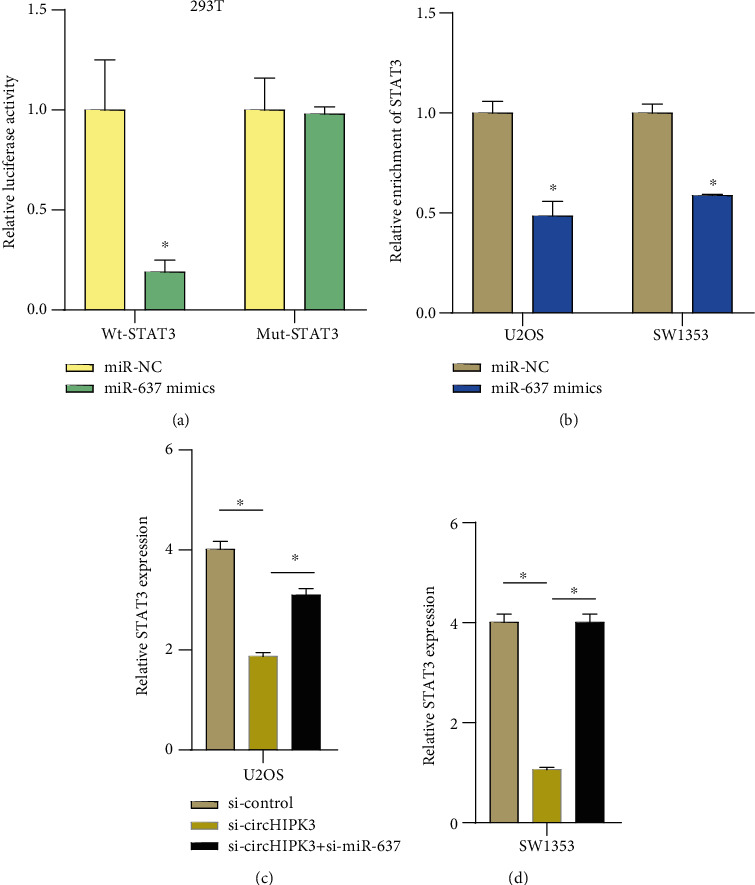
STAT3 was a direct target of miR-637. (a) miR-637 mimics significantly reduced the luciferase activity of Wt-STAT3. (b) miR-637 overexpression reduced STAT3 expression levels in U2OS and SW1353 cells. (c, d) miR-637 underexpression rescued the effects of circHIPK3 knockdown on STAT3 expression levels. ∗p < 0.05.